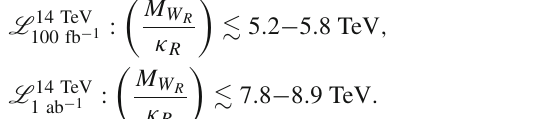
Fig. 2 a As a function of m N , observed 8 TeV LHC upper bound on ε μμ ( M ) ( dash-dot ),expected14TeVsensitivitywith L = 100 fb − 1 W R ( solid-triangle ) and 1 ab − 1 ( dash-dot-diamond ), and expected 100 TeV VLHC sensitivity with 10 ab − 1 (dot-star). b Same as a but with e ± μ ±